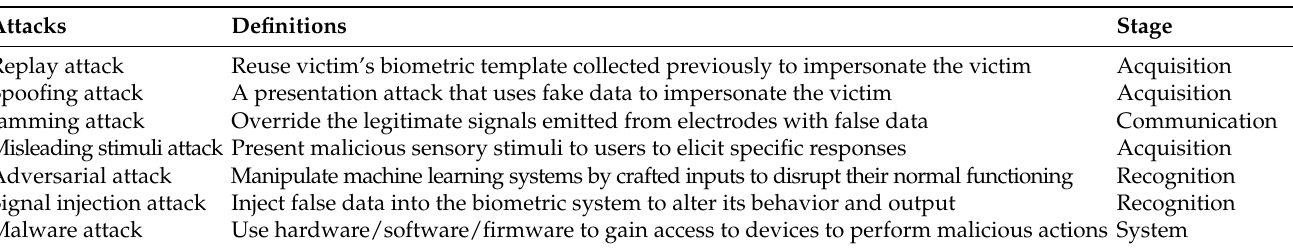
Table 7. Attacks on cognitive biometric